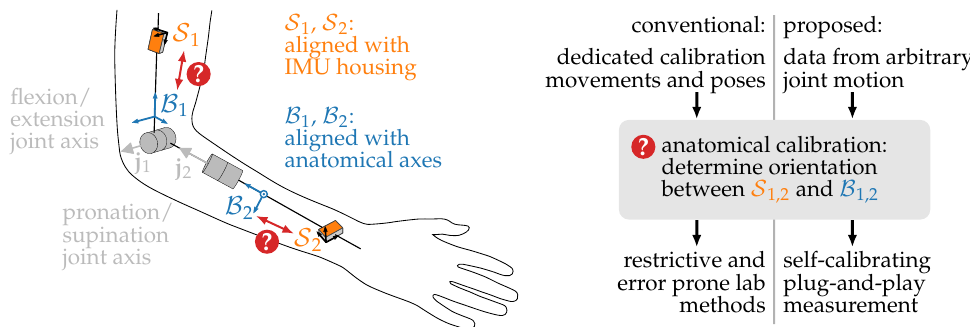
Figure 1. Anatomical calibration, also called sensor-to-segment calibration, is the task of determining how the IMUs are attached to the body segments. More precisely, the rotations between the IMU coordinate systems , defined by the sensor housing, and the corresponding body segments S 1,2 determined by anatomical axes such as the joint axes j 1,2 , have to be determined. Conventional methods rely on precisely defined calibration movements and poses, whereas the proposed methods use kinematic constraints to derive this information from arbitrary joint